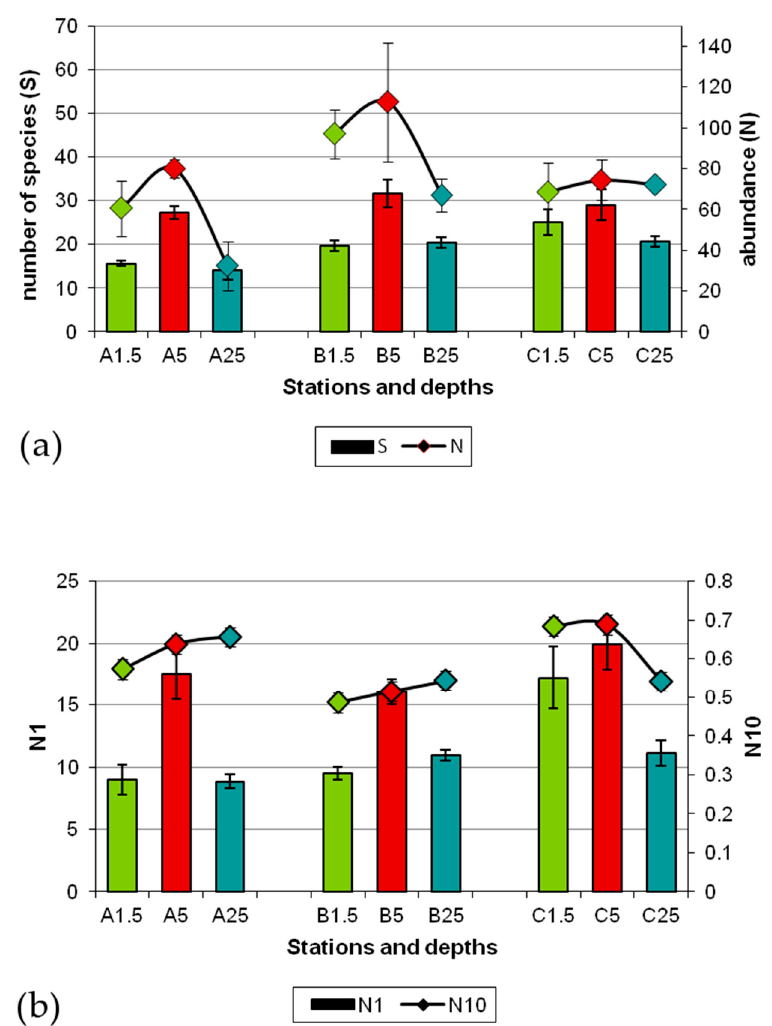
Figure 4. ( a ) Mean ( ± SE) total abundance (N; lines) and species richness (S; bars); ( b ) Mean ( ± SE) Hill’s species diversity index (N1; bars) and Hill’s evenness index (N10; lines) at each studies station and depth. Table 1. Results of PERMANOVA and PERMDISP analyses (untransformed data) testing for differences in abundance (N), species richness (S), Hill’s species diversity index (N1), Hill’s evenness index (N10) and structure (Stru) of polychaete assemblages between stations (st) and depths (de). df, degrees of freedom; SS, sum of squares; MS, mean squares; Up, unique perms; F, F -ratio; P (perm), probability. Significant p -values ( p < 0.05) are given in bold.